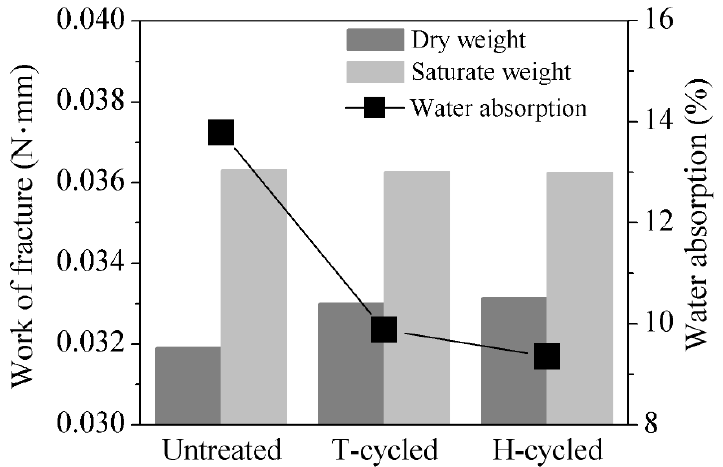
Figure 6. Averaged weights of the specimens after different treatments and the water absorption